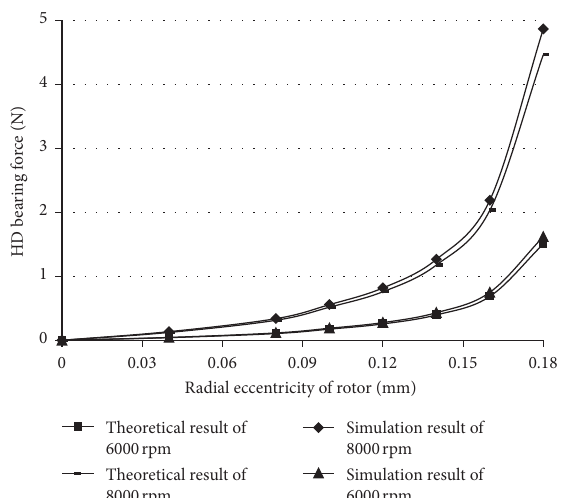
Figure 13: The electromagnetic force acting on the rotor in a circle at different rotating speeds.